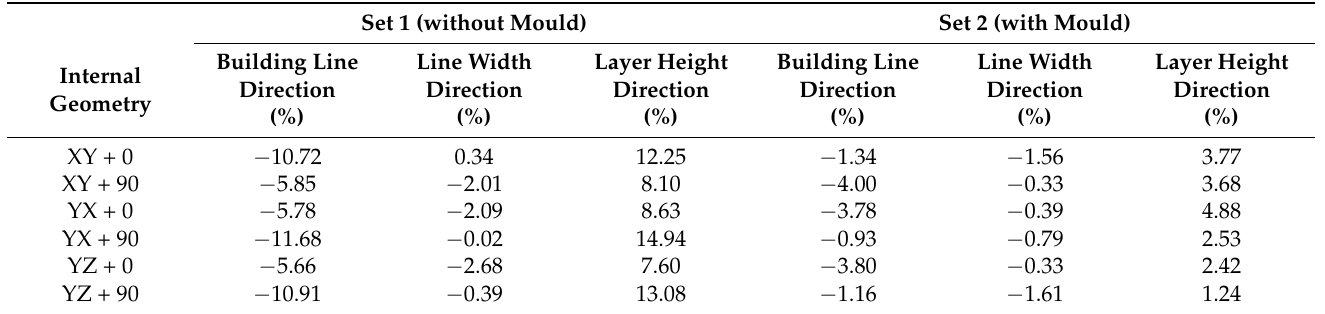
Table 9. Deformations between dimensions of the building lines and the directions of the sample dimensions for each type of internal sample